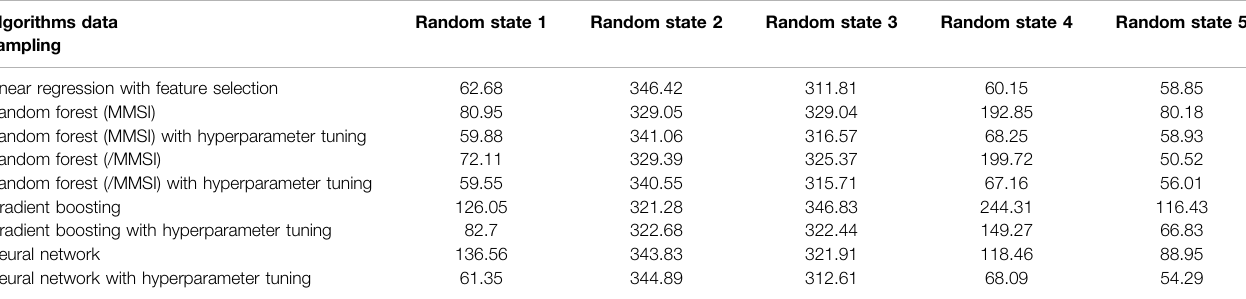
TABLE 1 | RMSE of each prediction model of the test